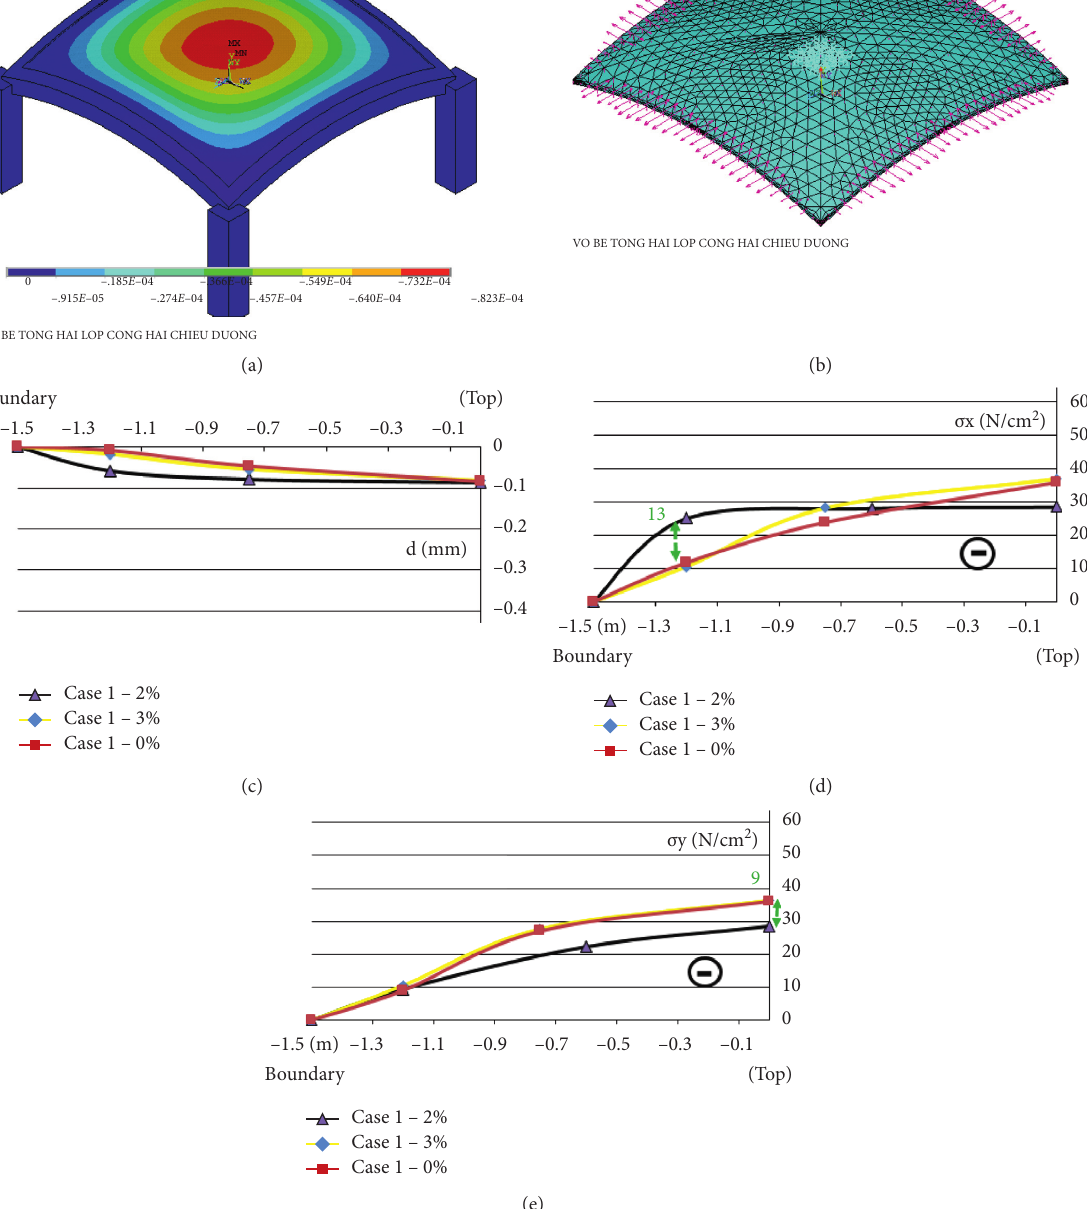
Discussion of Result . In Figure 19, the vertical dis- placement of the shell is similar to the three cases above where the SFCL is placed on top of NCL. However, the stress values σ x and σ y start to change in the direction of increasing the stress value, and the stress at the top of the shell increases from 39 to 50 N/cm 2 . The percentage